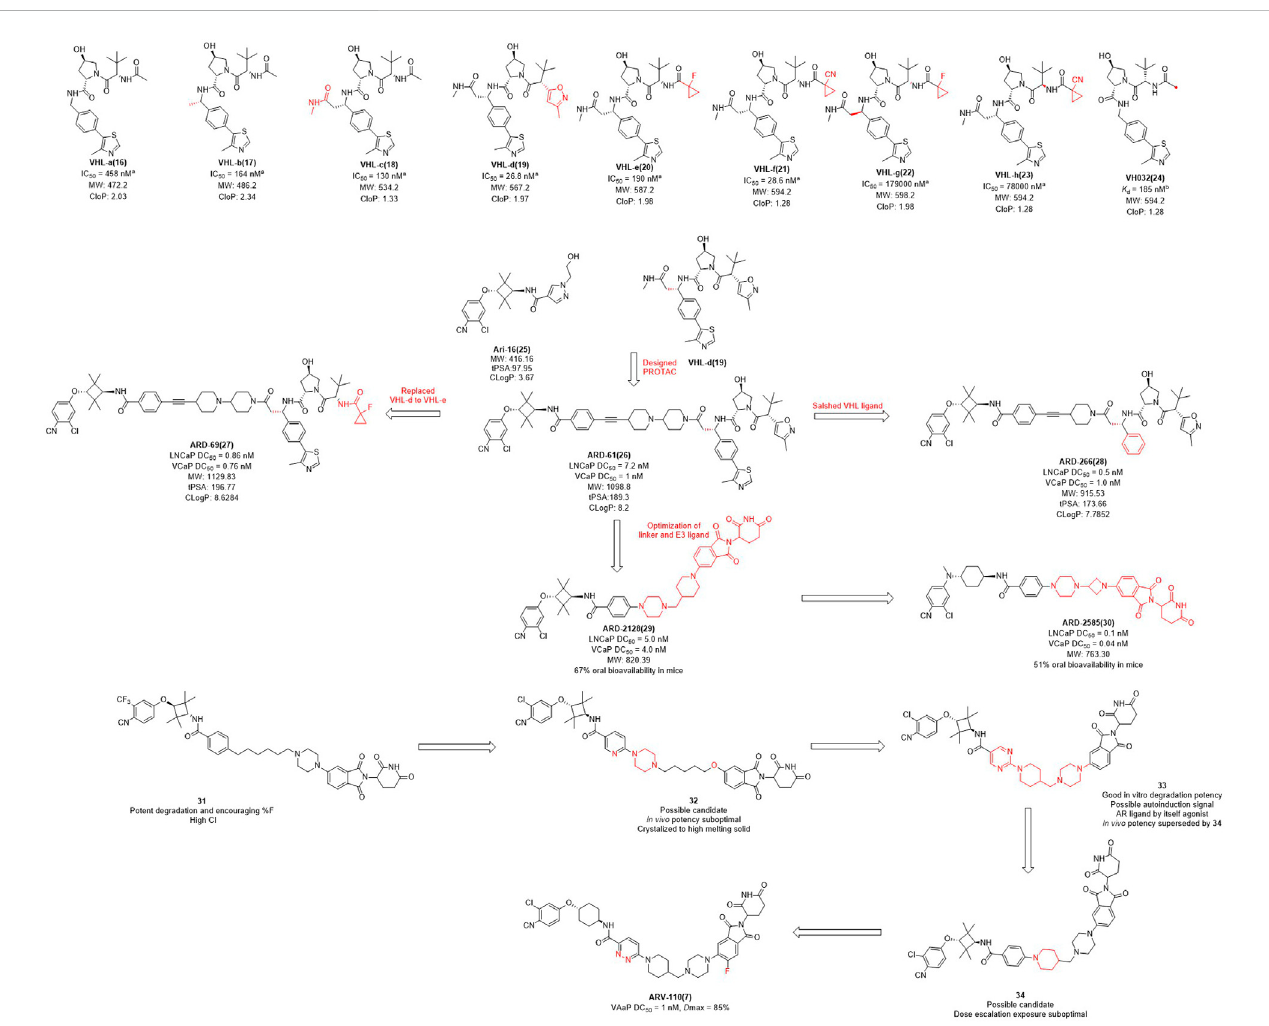
FIGURE 2 Chemical structures of VHL ligands and their binding af fi nities to VHL protein and the design and optimization of AR PROTACs. a Inhibitory activity (IC50) of E3 ligands on their substrates. b inding af fi nity (Kd) of E3 ligands to their respective substrates MW, molecular weight; tPSA, total polar surface area; cLog P, calculated Log P; *The arrows in the fi gure do not mean progressive relationship between these